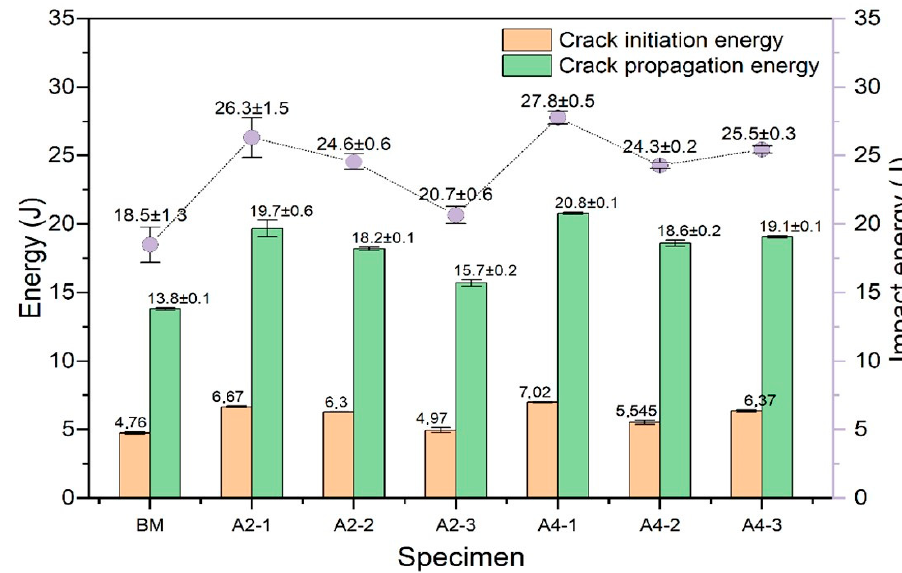
Figure 11. Charpy impact test results.